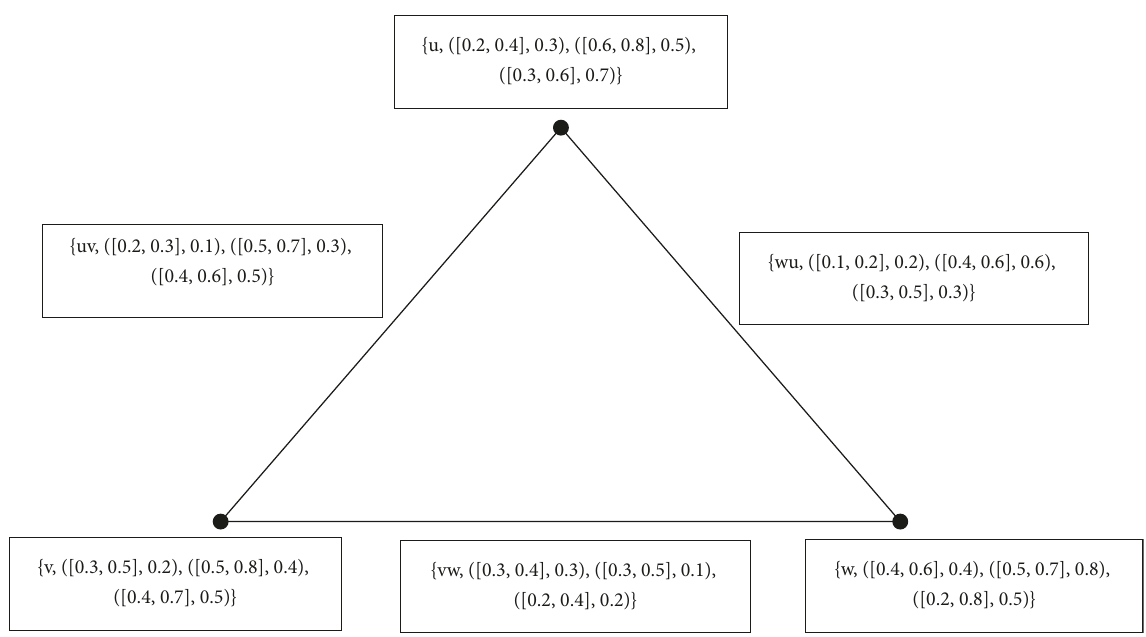
Figure 7: G is SEI-NCG, but it is not